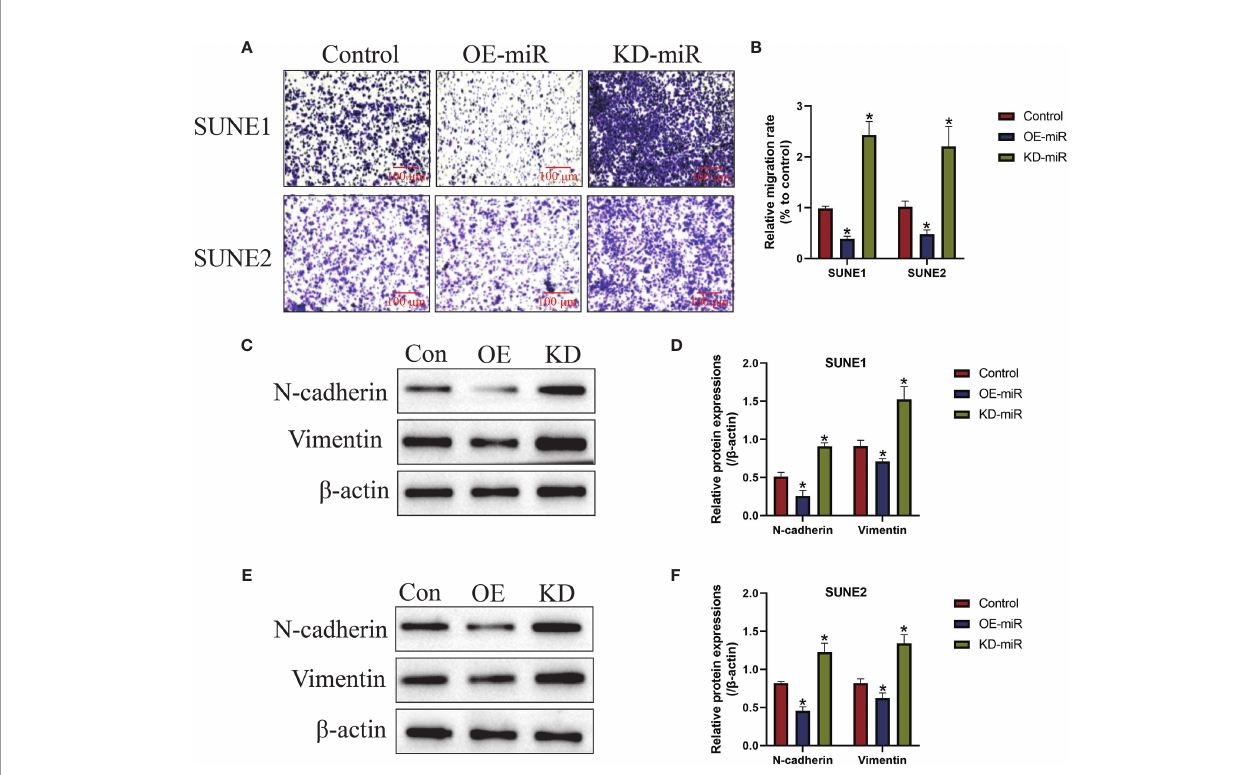
FIGURE 3 | The regulating effects of microRNA-338-5p on cell migration and epithelial-mesenchymal transition (EMT). (A, B) Transwell assay was employed to detect cell migration abilities in NPC cells. (C – F) Western Blot analysis was conducted to examine the expression levels of EMT associated proteins (N-cadherin and Vimentin) in NPC cells. Each experiment repeated at least three times, and * P <